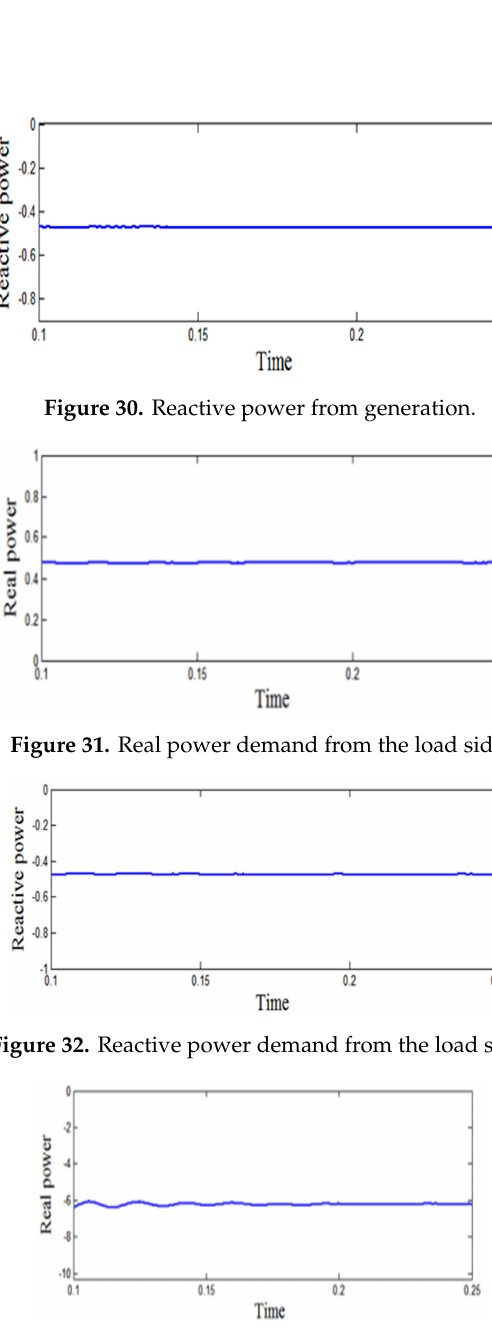
Figure 33. Real power from bidirectional converter.